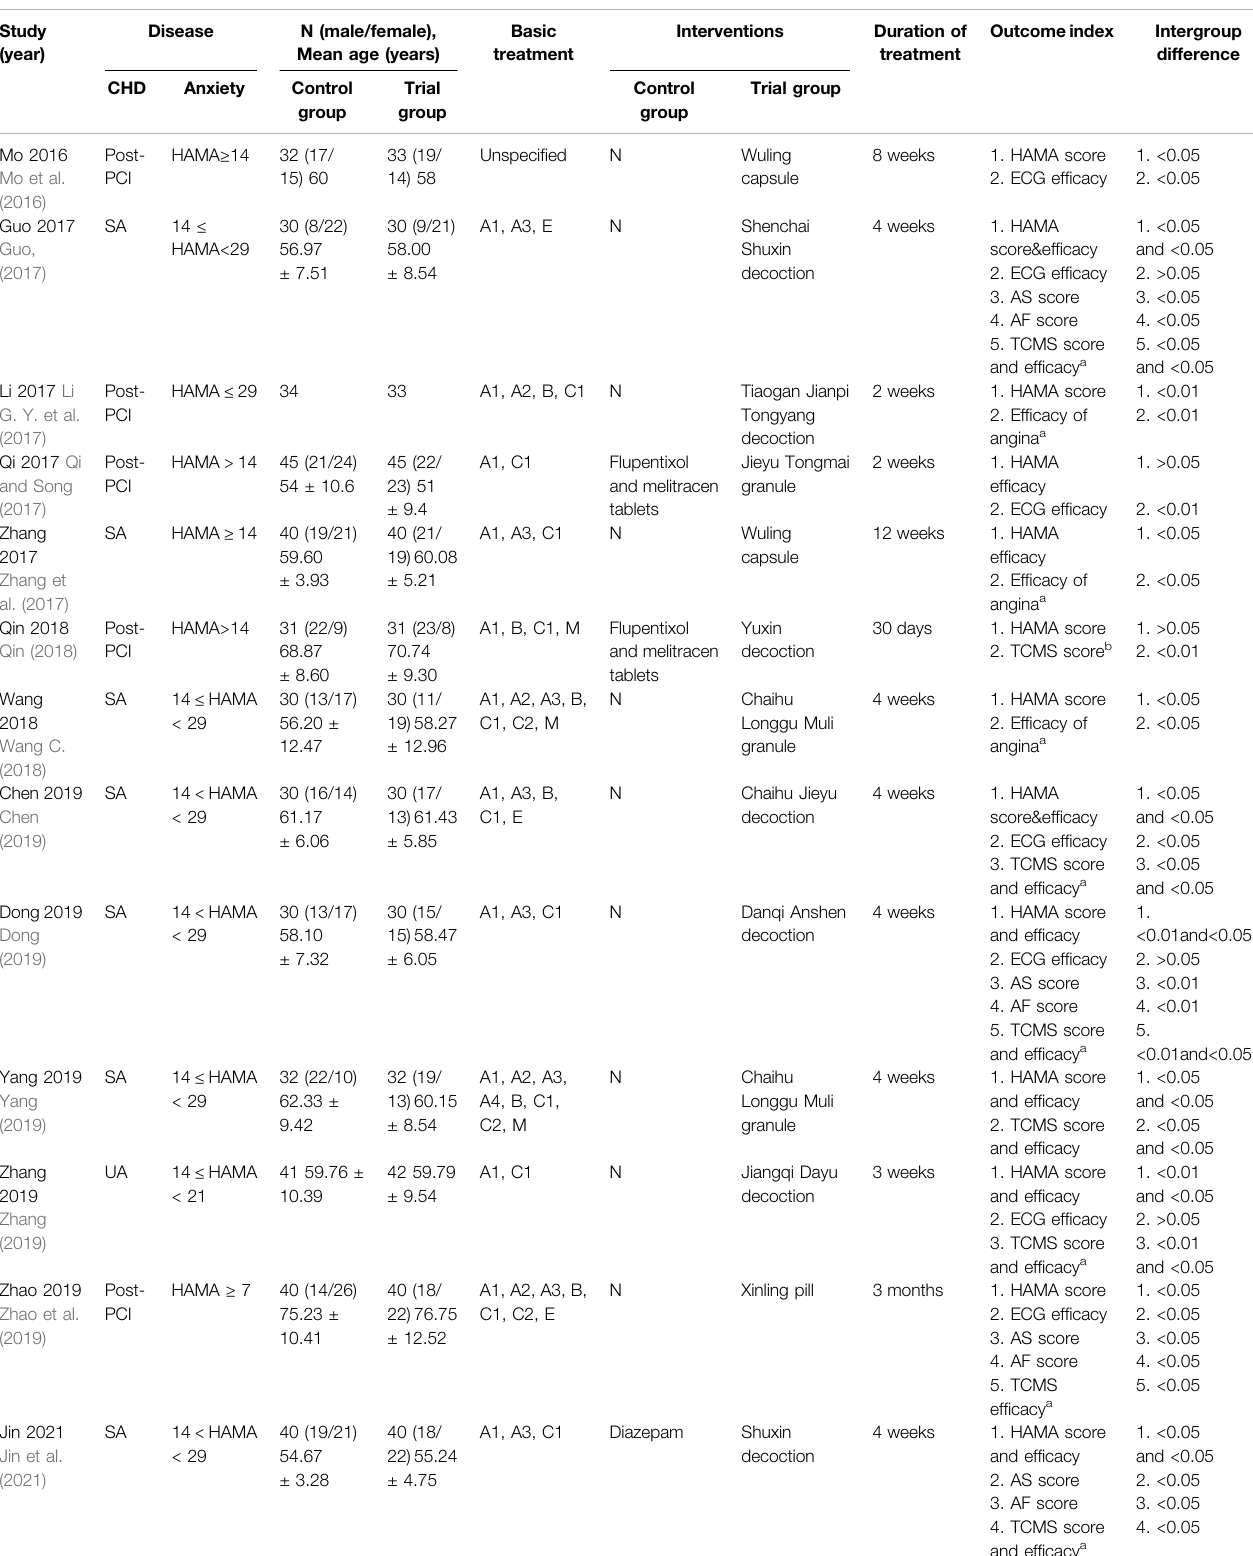
TABLE 2A | Research characteristics of the CHD with